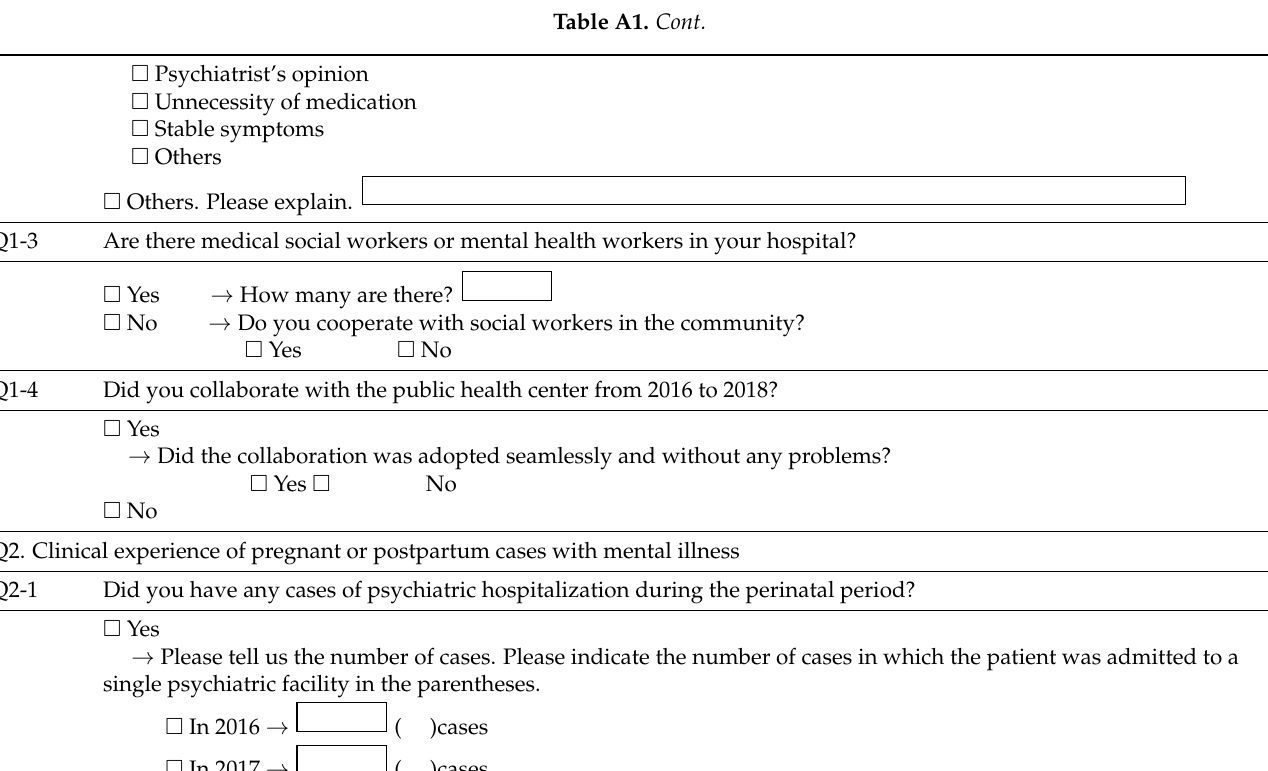
Table A1. Questionnaire for maternity care units.